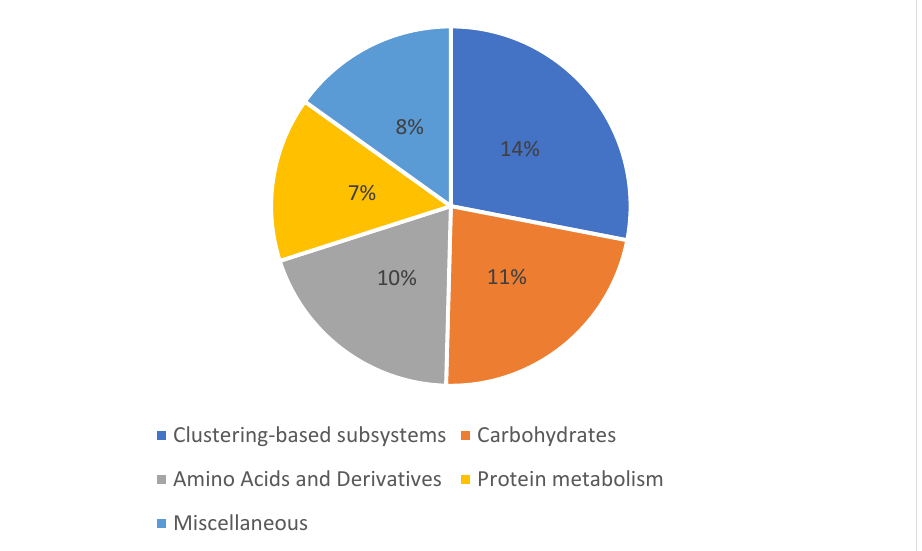
Figure 8. Functional category hits distribution annotated using MG ‐ RAST Subsystems classification in Marchica lagoon (OSD24).